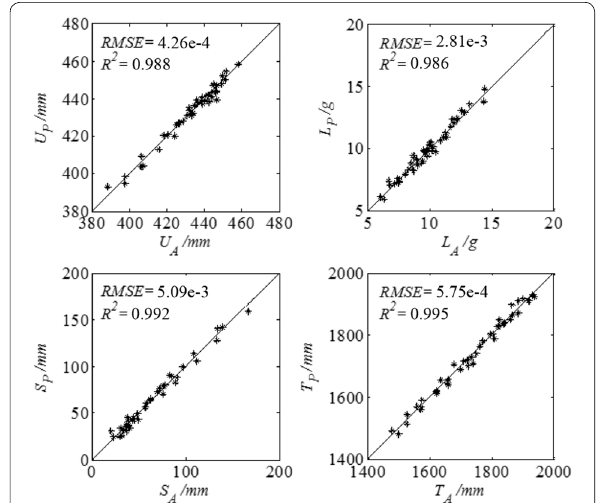
Figure 16 Scatter diagram for fitting precision of response